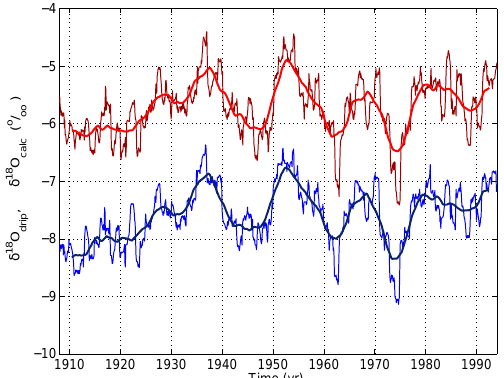
Fig. 3. Time series of the simulated monthly mean (speleothem δ 18 O calc and δ 18 O drip values at Bunker Cave). The thick lines show the 60-month running